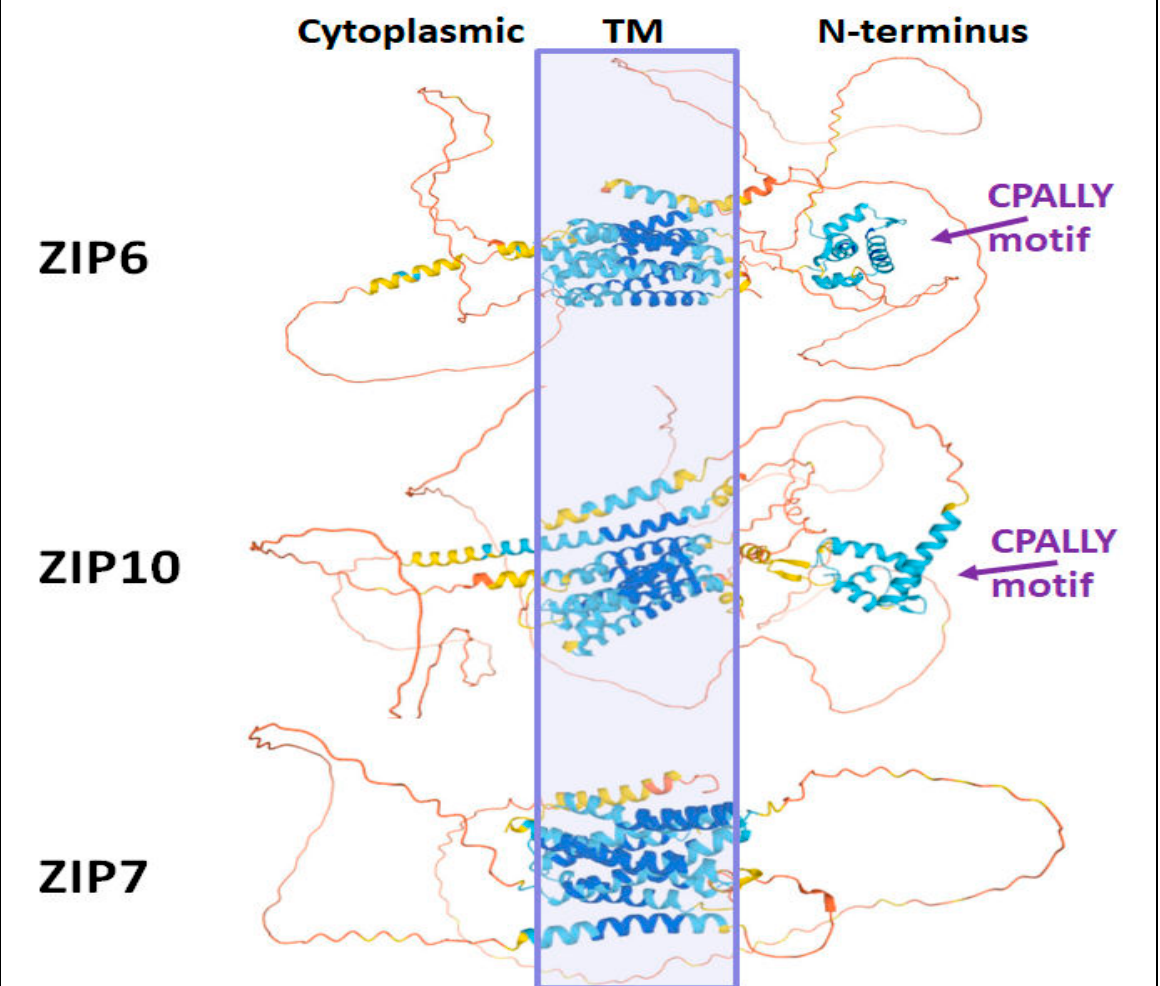
Figure 5. AlphaFold diagrams of three LIV-1 family members. AlphaFold diagrams of the predicted tertiary structures of three LIV-1 family members. ZIP6 and ZIP10 structures demonstrate the long extended TM2 region whereas ZIP7, which resides intracellularly, does not have this. The presence of the N-terminal CPALLY motif is also visible. The blue box roughly shows the position of the TM domains.